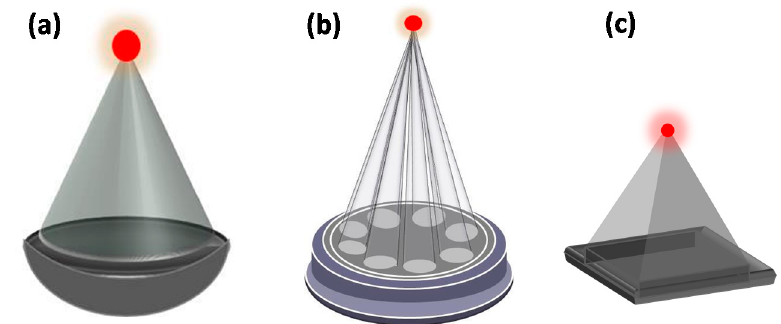
Figure 2. ( a ) Schematic of a concave focusing transducer and ( b ) an arranged multiple piston transducer or the atruncated surface of a spherical bowl ( c ) fully populated phased array.